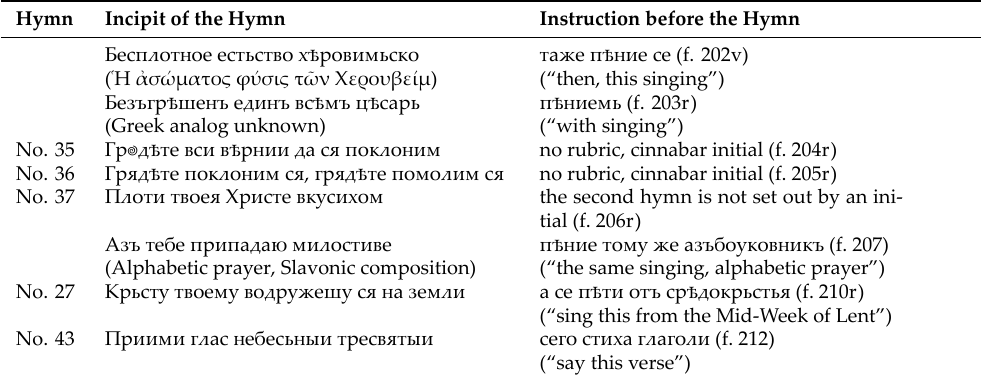
Table 2. The kata stichon hymns of Compline in the Yaroslavl